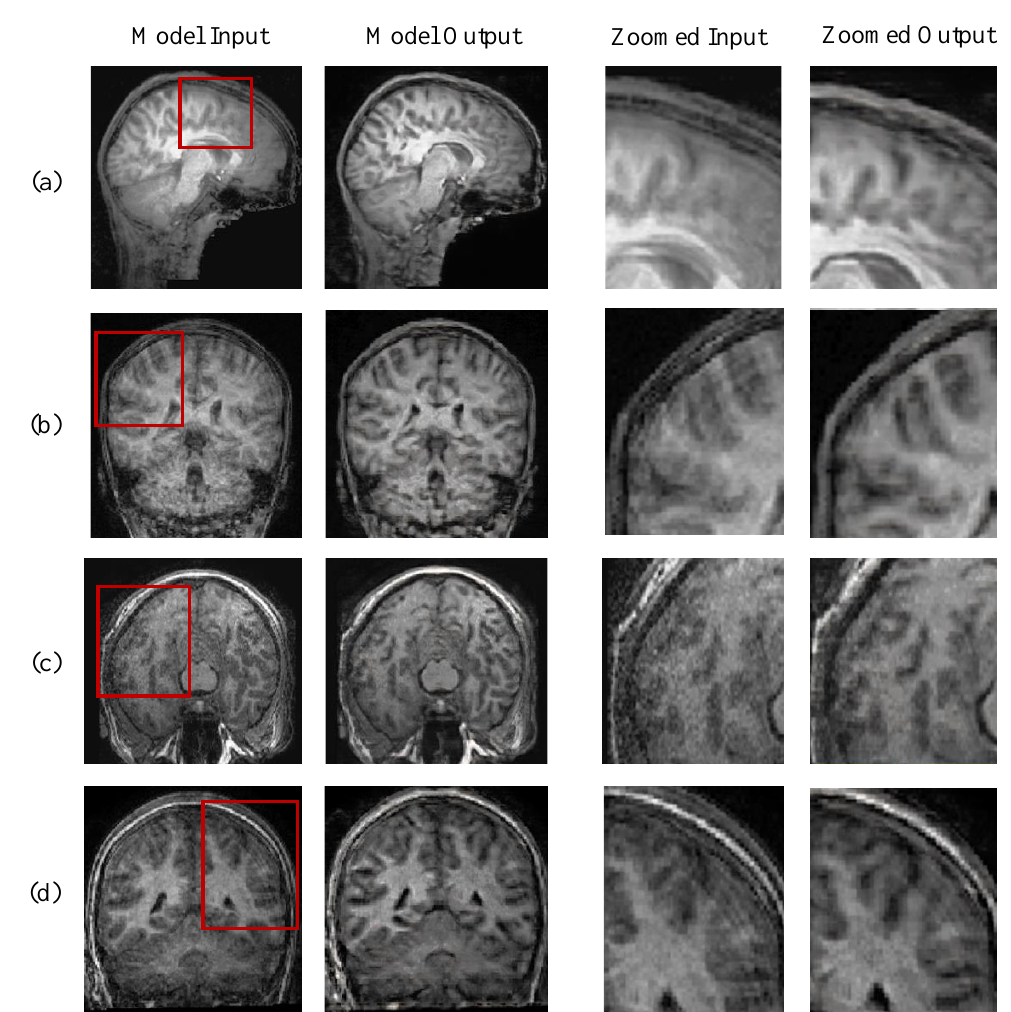
Figure 5. Visual Assessment of MC-GAN on Real-world Motion-affected Images. Images under the “Model Input” columns are original MR images; model-corrected output is displayed to the right. The two columns on the right show the zoomed-in regions indicated by the red boxes. Samples are selected from the sagittal ( a ), coronal ( b , d ), and axial ( c )